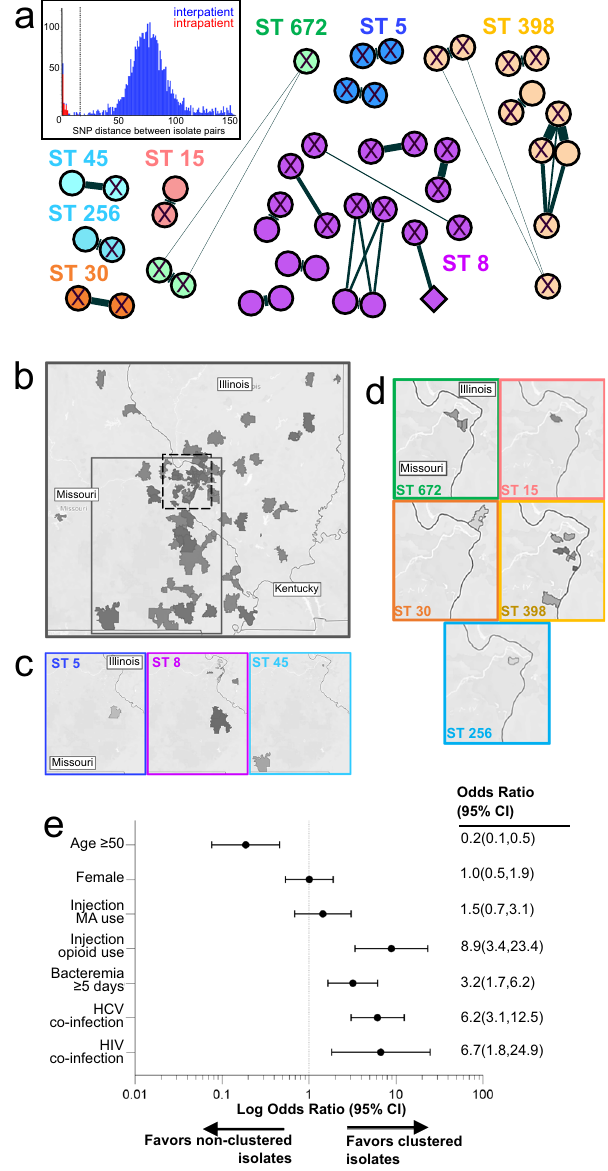
Fig. 4 Clonal outbreaks of diverse lineages among persons who inject drugs. a Networks of isolates with ≤ 15 core genome SNPs. Each node represents one of 46 index isolates, and are color coded by MLST, shaped according to whether associated with IDU-BSI (circle) or non- IDU BSI (diamond), and labeled according to HCV serostatus ( ‘ X ’ denotes HCV co-infection). Edge length and width represent SNP distance between nodes. Inset , histogram depicting collective core genome SNP distances between isolate pairs obtained from separate patients ( “ interpatient ” , blue) or from the same patient ( “ intrapatient ” , red). For clarity only comparisons with <150 SNPs are displayed. Dotted line denotes the 15 SNP cutoff used to de fi ne clonal relationship between isolates. b – d Heat maps of BSI patients ’ zip code of residence for all isolates (panel b ), or for isolates included in panel a (panels c , d ). In panel b , areas denoted by dashed or gray lines are magni fi ed in panels c and d , respectively. e Odds ratio comparting the characteristics between isolates included in panel a ( “ clustered) and all other isolates in the cohort ( “ non-clustered ” ). MA,